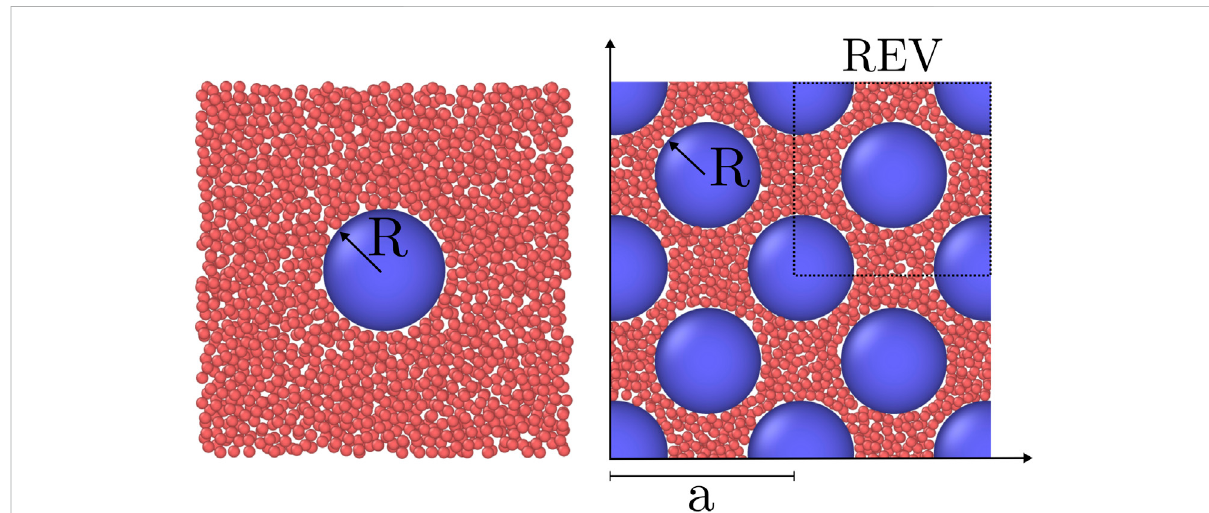
FIGURE 2 Visualizationofatwoofthesimulatedsystems.Fluidparticles(red)andsolidparticles(blue)arevisualisedwithOVITO[32].Onlytheparticlesina slabcenteredonthesolidparticlesofthickness2.5 σ isshown.The fl uidchemicalpotentialis μ f = ξ andtheradiusofthesolidparticleis R =5 σ ,where ξ is the minimum of the interaction potential and σ is the soft-core diameter of the fl uid particles. Left: Single solid particle. Right: An fcc lattice with lattice constant a = 17.5 σ and porosity ϕ =